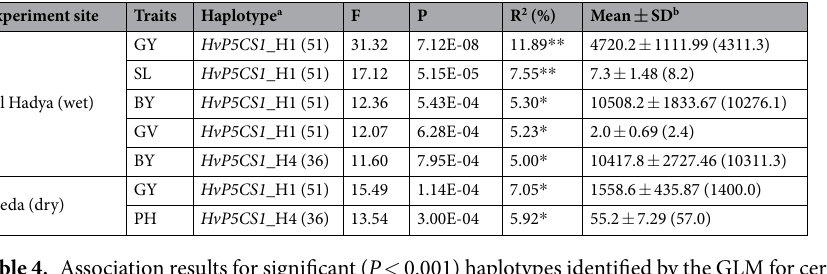
Table 4. Association results for significant ( P < 0.001) haplotypes identified by the GLM for certain agronomic traits in 227 barley accessions. a The numbers of accessions identified to carry the same haplotype are given in brackets. b Weighted means for other haplotypes than targeted haplotypes (e.g. HvP5CS1_ H1) are given in